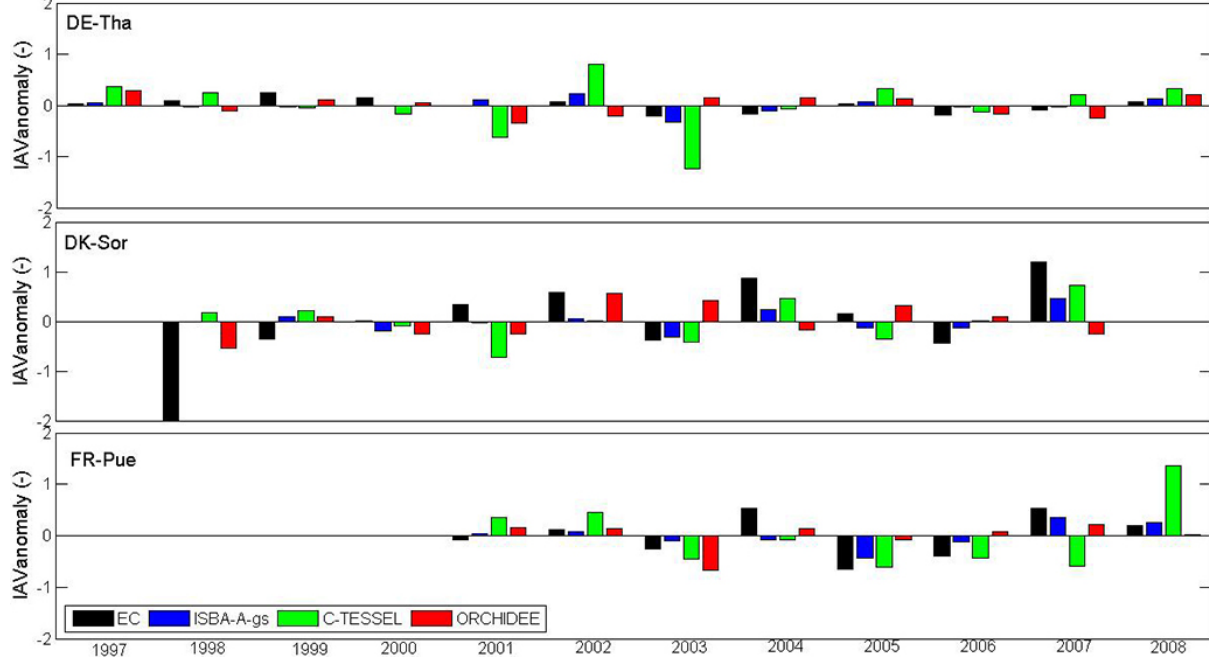
Figure 5. IAVanomaly of NEE for three forest sites: from top to bottom, DE-Tha, DK-Sor, and FR-Pue. ISBA-A-gs, CTESSEL, and OR- CHIDEE anomalies are in blue, green, and red, respectively. EC-derived anomalies are in